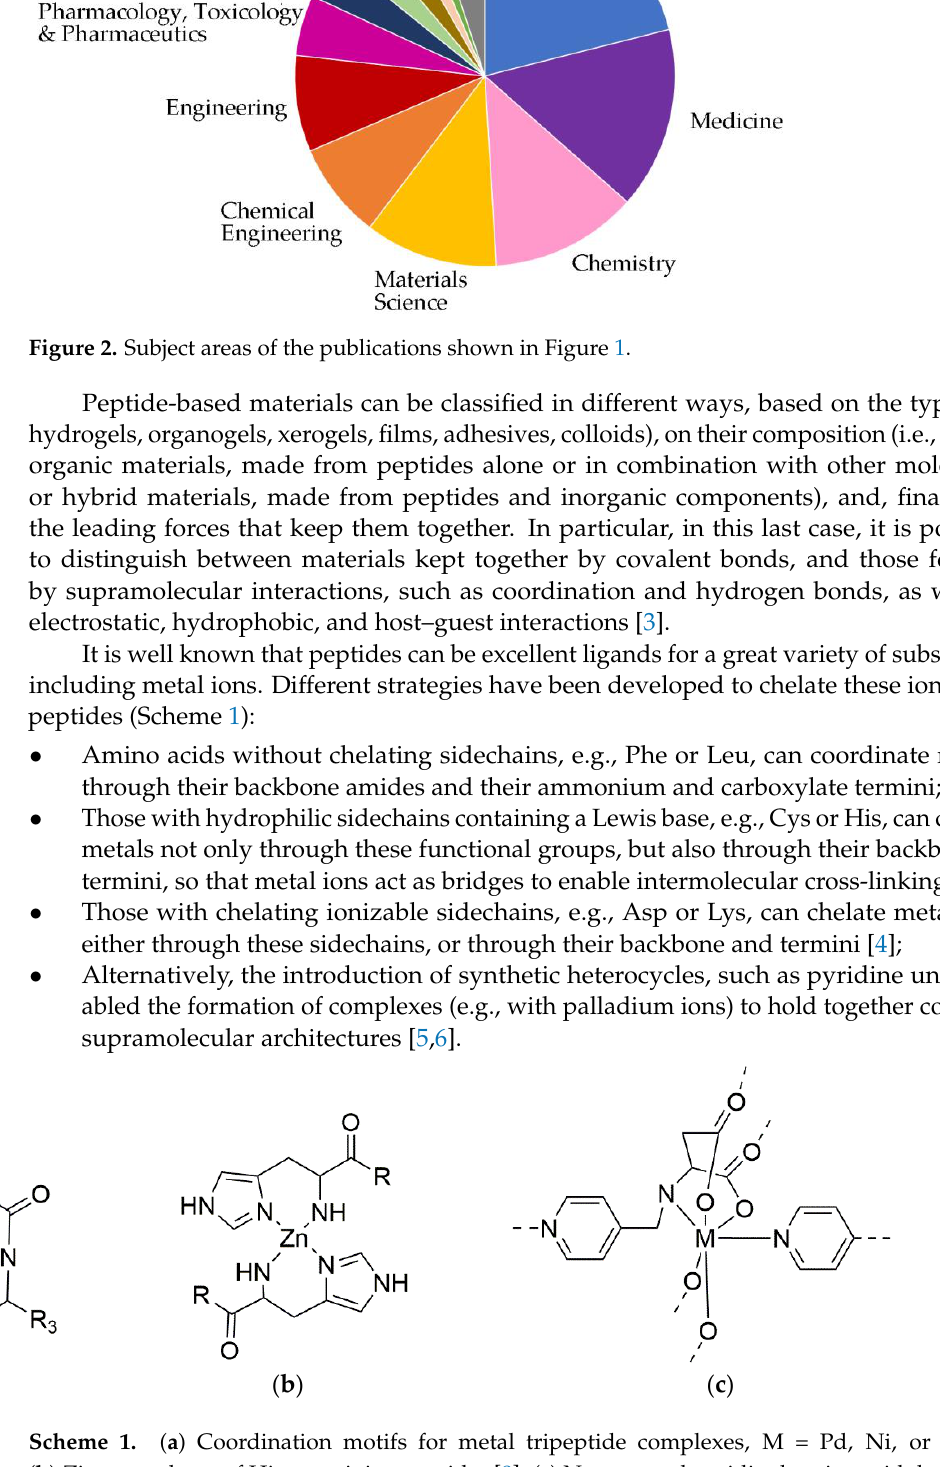
Figure 1. Nu mber of publications in the last century present on Scopus containing “peptide AND